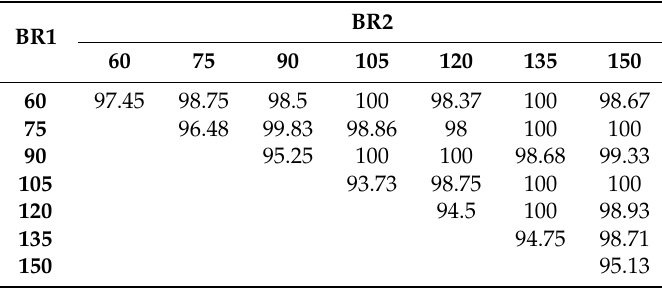
Table 2. SFD detection accuracy—FAAC